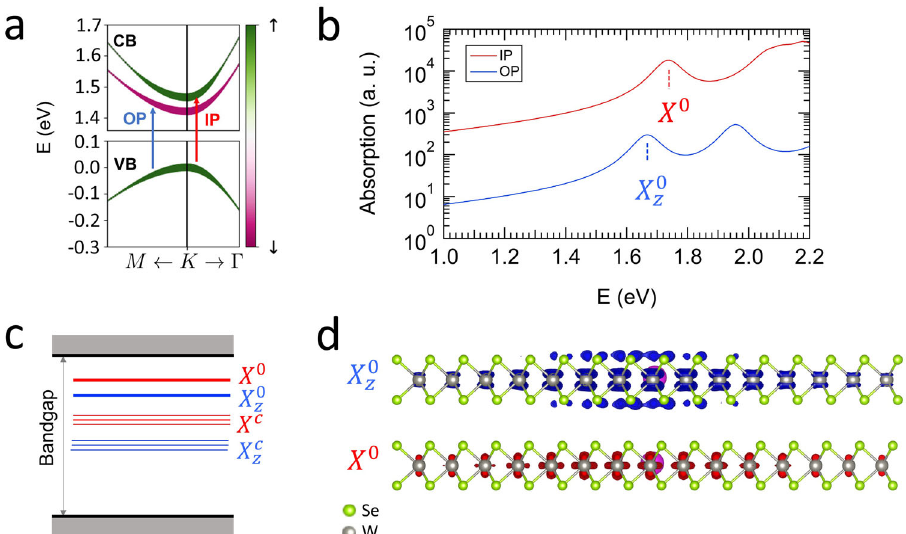
Fig. 4 Optical selection rules for excitons and trions. a Band structure of monolayer WSe 2 calculated by using LDA along the M-K- Γ high-symmetry direction. The color code indicates the spin projection of each band. The width indicates the contribution of each band, at the K-point, to the excitonic wavefunction of the excitons X 0 (IP transition) and X 0 (OP transition). b Optical absorption for IP and OP con fi gurations, in logarithmic scale. The ground z excitonic states of each spectra are denoted as X 0 and X 0 . c Scheme of energy levels of excitons and trions. The trions X c and X c inherits the z z optical selection rules of the excitons X 0 and X 0 , respectively. d Wave functions of the excitons X 0 and X 0 . The position of the hole is fi xed (pink sphere) z z near the W atom and we represent the electronic density. The maximum is set to 1 and we fi x the isosurface value to 0.1 for both wave